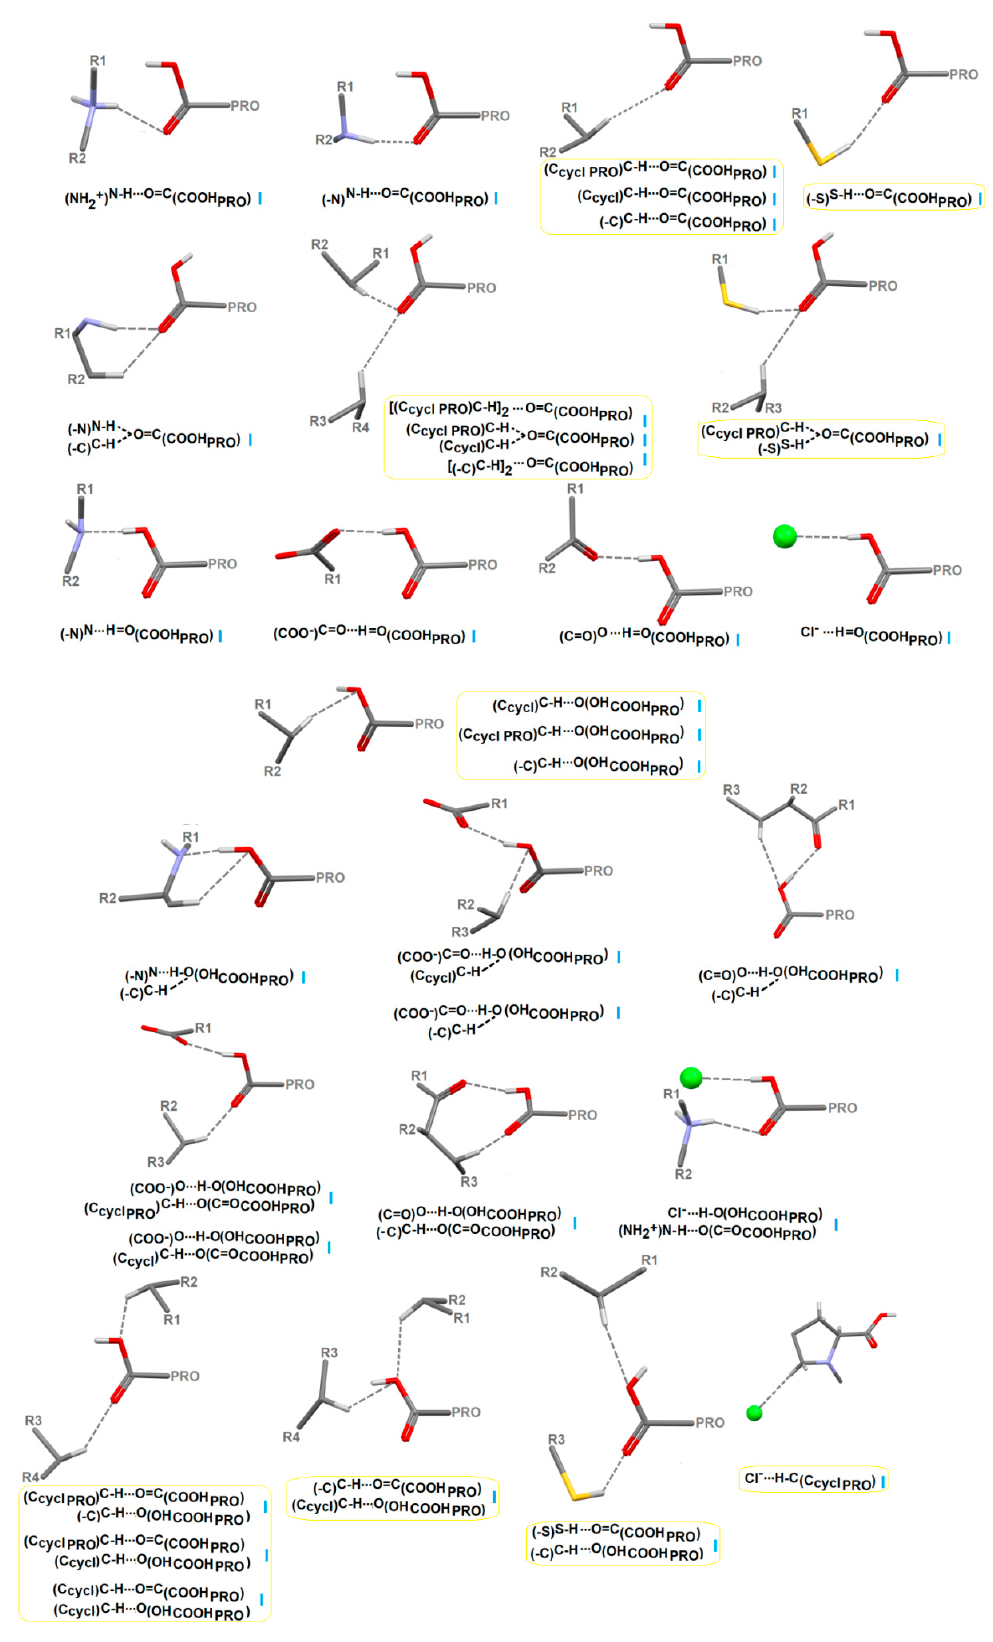
Figure 10. Supramolecular synthons resulting from three types of proline-based tectons observed in ACEI structures (three types of proline-tectons are color coded: I-blue, II-green, III-pink; synthons forming only by weak interactions are marked in yellow frames).